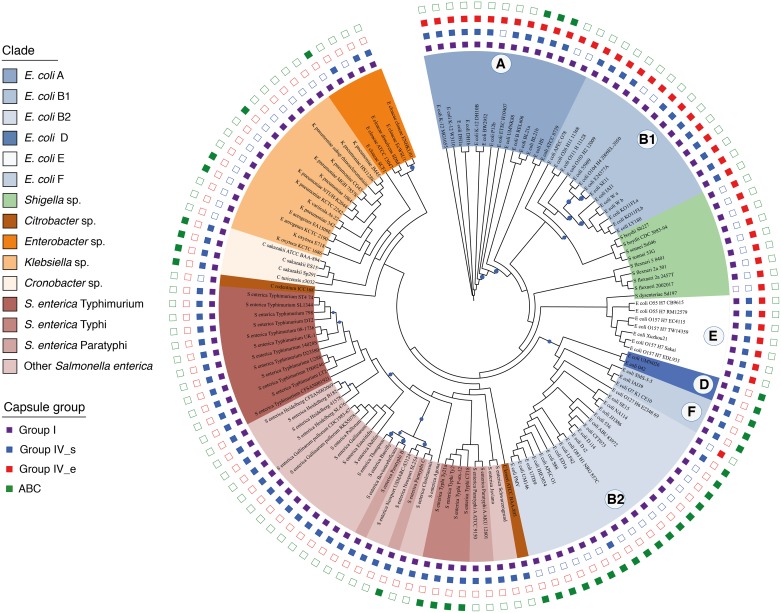
Cladogram of selected enterobacterial species and the capsule groups detected in their genomes.The tree was built using the protein sequences of the 759 families of the core genome of Enterobacteria. Squares on the outer part of the tree indicate the presence (full) or absence (empty) of different capsule systems in the corresponding genomes. Background colour indicates the phylogenetic group of each genome. The size of the circles along the branches are proportional to bootstrap values ranging between 20 and 99. Absence of circles indicates a bootstrap of 100%.